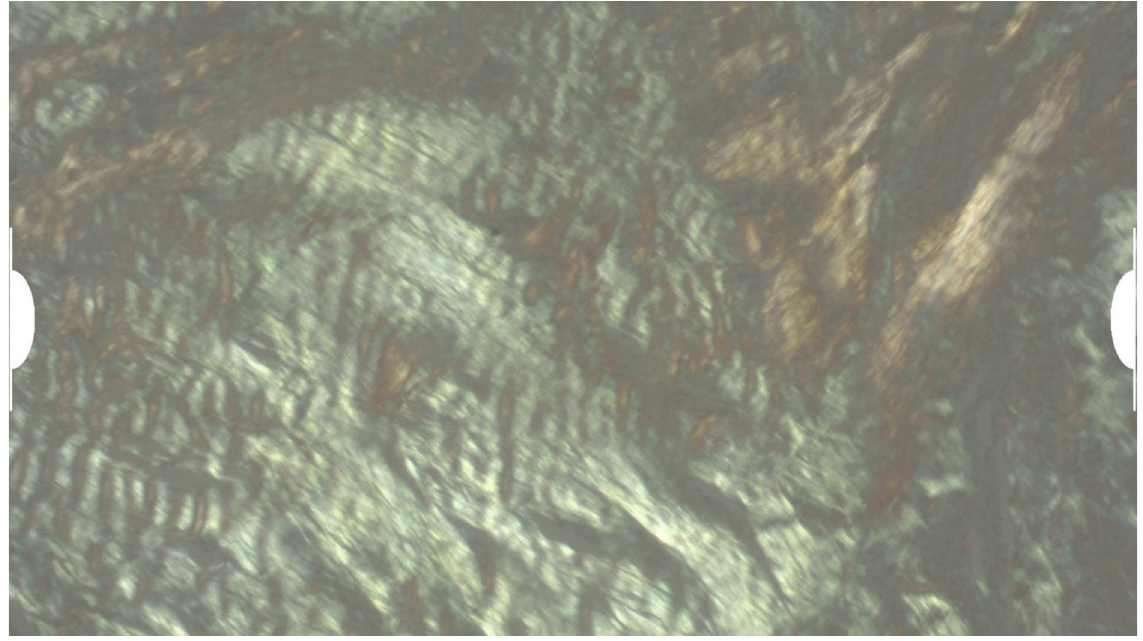
Figure 5: Collagen accumulations showing apple-green birefringence of amyloid under polarized